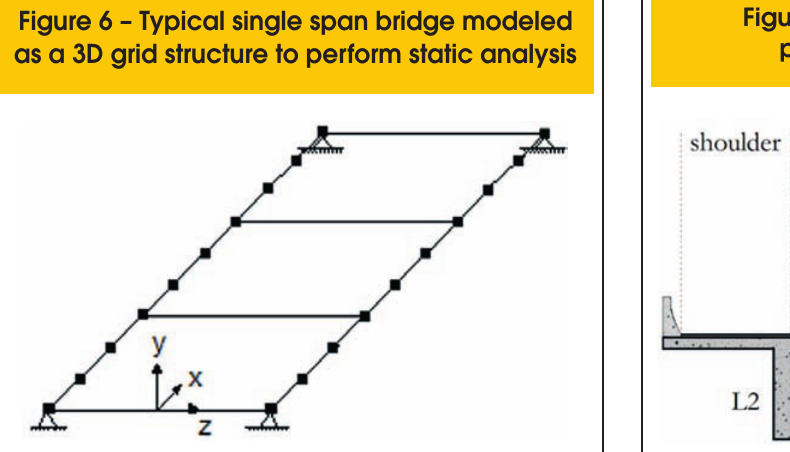
Figure 7 – Most frequent transverse position of vehicles